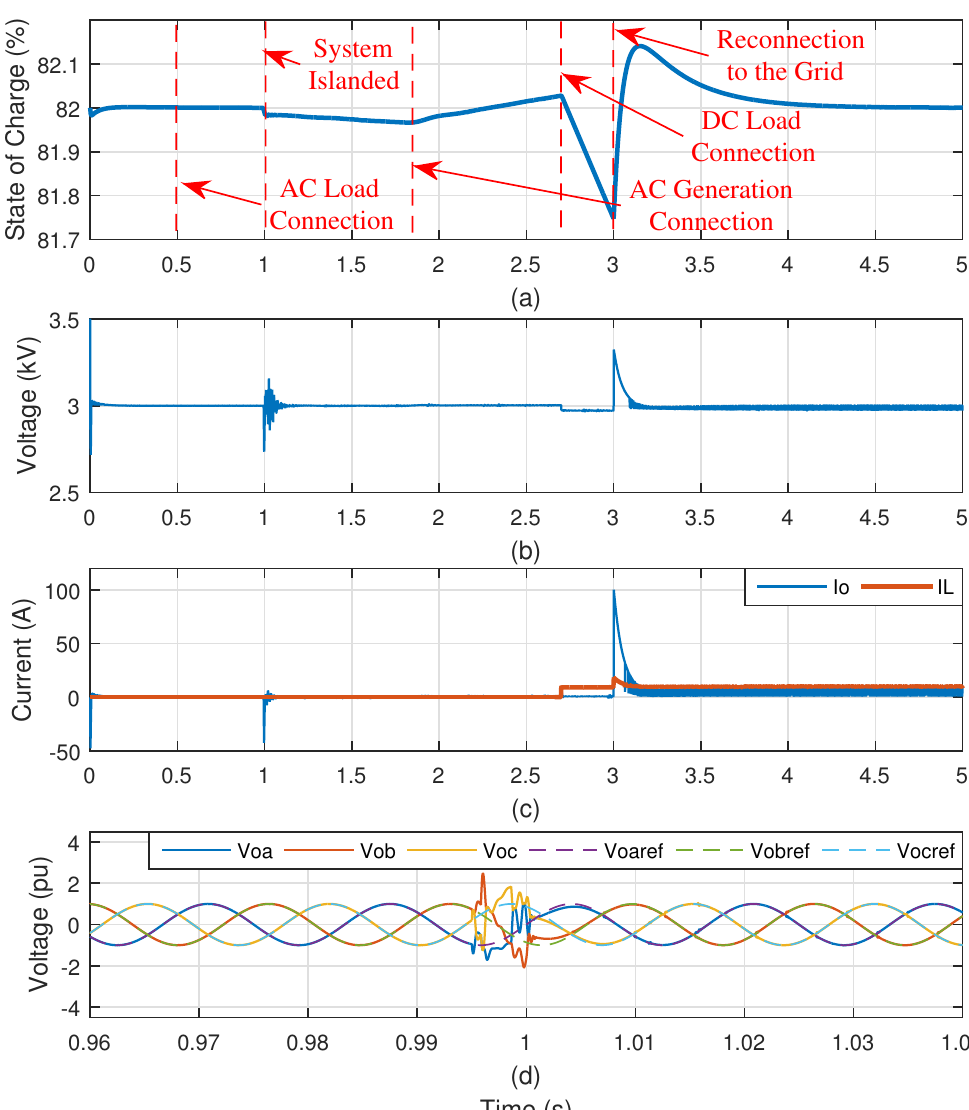
Figure 20. Hybrid DMC operation. ( a ) Battery SOC, ( b ) DC output voltage, ( c ) DC output current, and ( d ) AC output